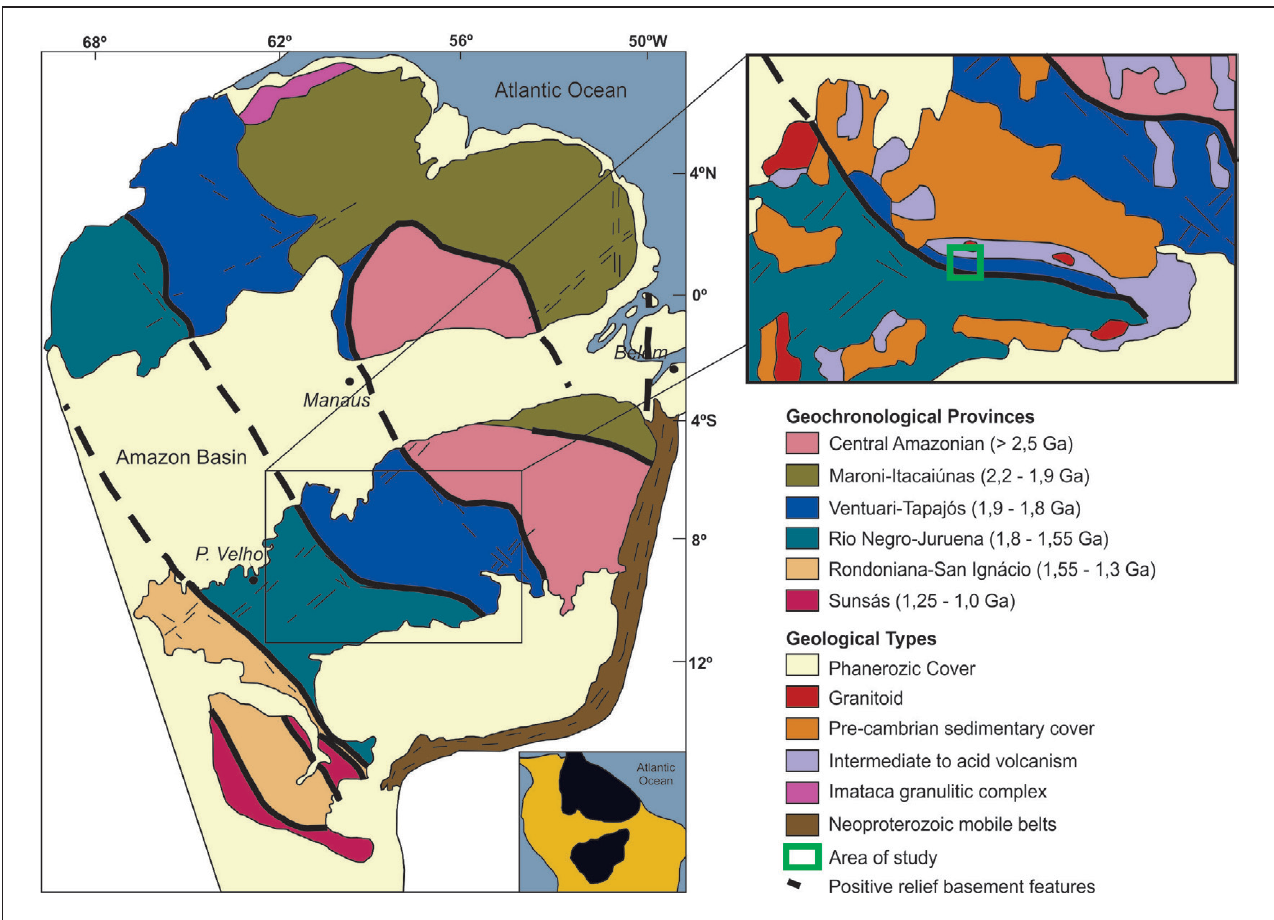
FIGURE 1 - Distribution of the Geotectonic/Geochronological Provinces in the Amazon Craton and location of the study area in the detailed map. modified from Tassinari and Macambira (1999) with a detailed map of the SW portion of the Craton. Province range from 1.8 to 1.55 Ga. A NW-SE